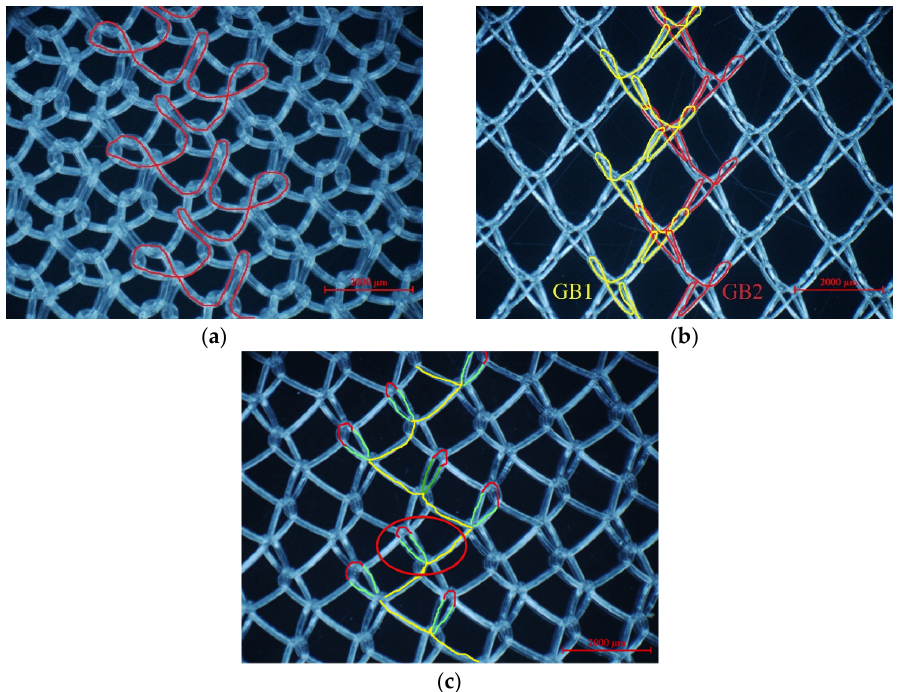
Figure 1. Illustrations for warp ‐ knitting structure. ( a ) Device No. 6 ‐ 1; ( b ) Device No. 9; ( c ) Device No. 2.